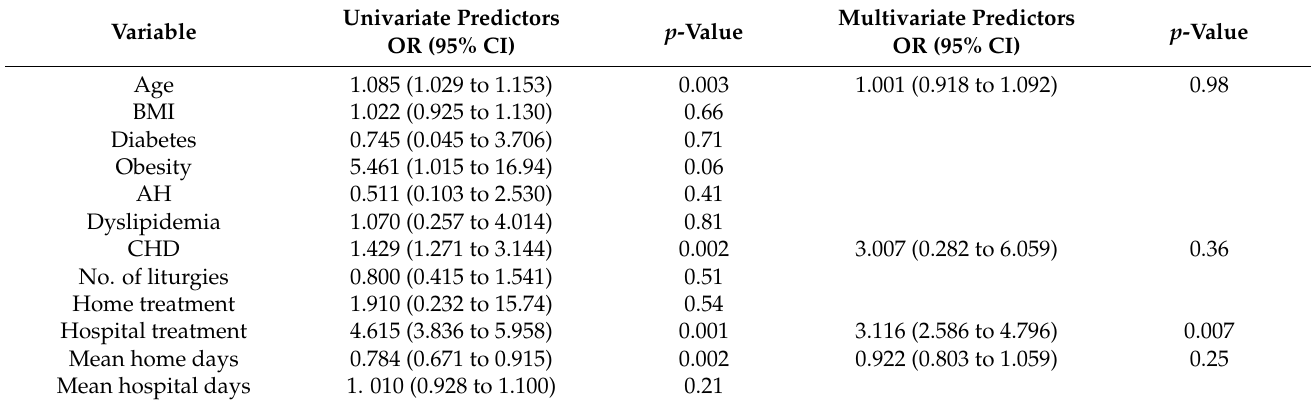
Table 4. Predictors of death among infected clergy.